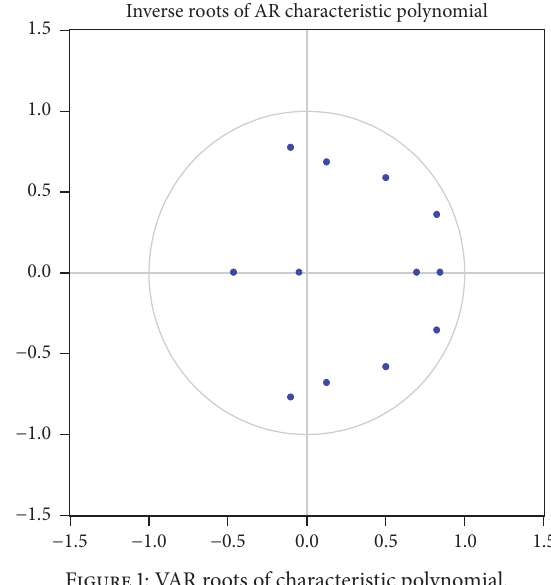
Figure 1: VAR roots of characteristic